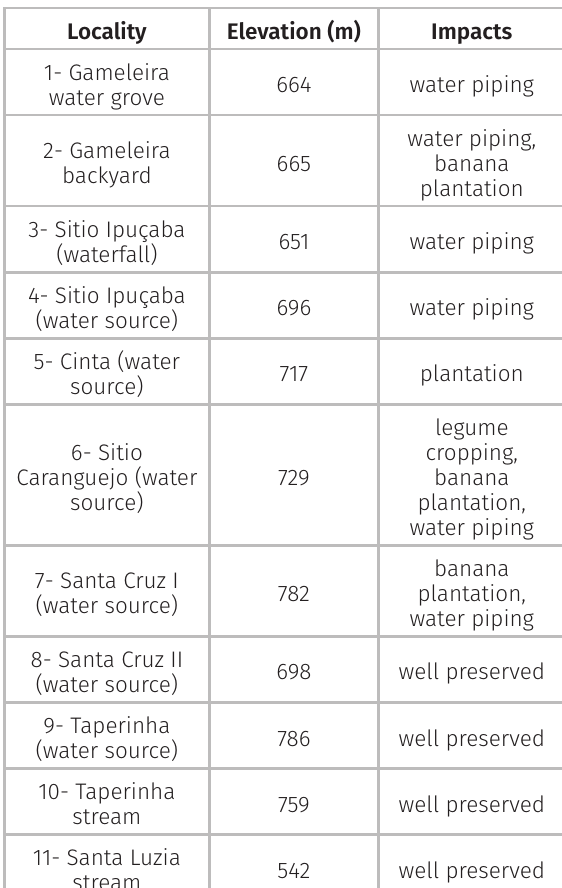
Table I. Localities surveyed for Fredius reflexifrons (Ortmann, 1897) in Planalto da Ibiapaba, Northeastern Brazil, with their respective elevations and anthropic